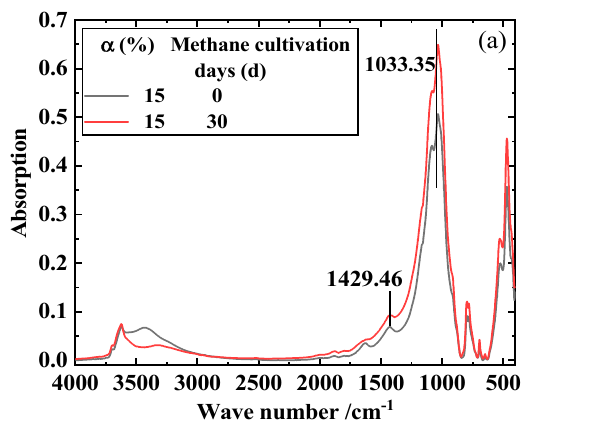
Figure 17. Variation in functional groups of the biochar—methanotroph—clay mixture ( α = 15%) under different methane cultivation days: ( a ) variation in functional groups; ( b ) enlarged